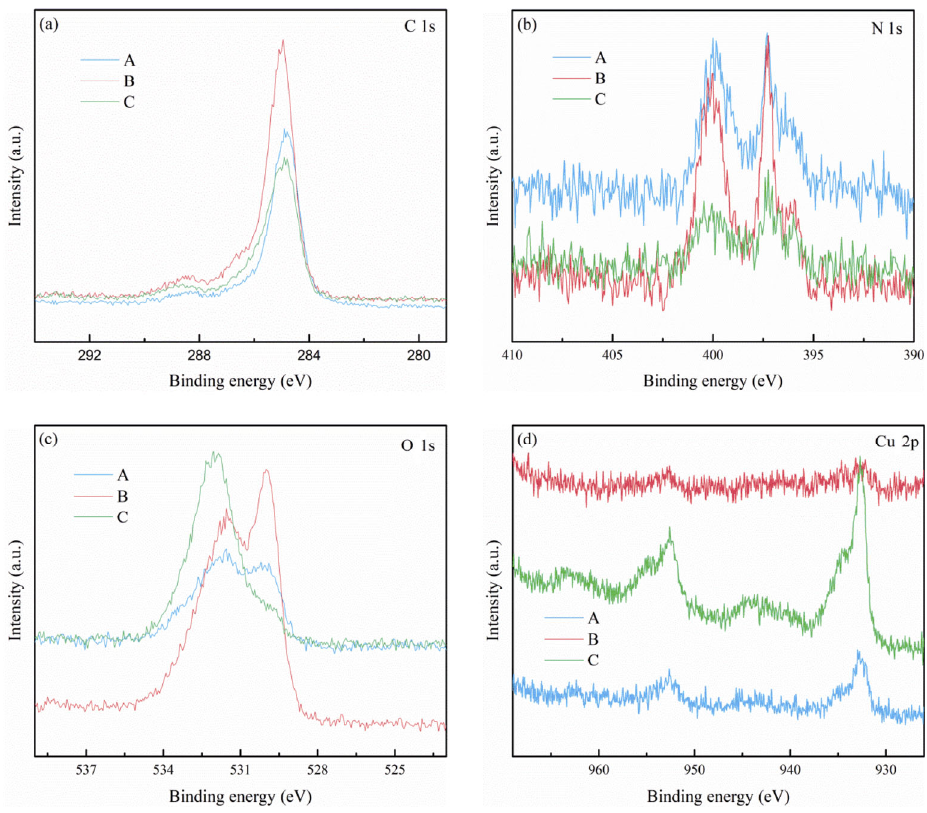
Fig. 10 XPS spectra of several elements on the worn surface of (A) TiN–Ag of 30 at% Ag content, (B) TiN–Ag of 10 at% Ag content, and (C) TiN–Ag of 2 at% Ag content lubricated with MGLG (voltage: 1.5 V; load: 15 N).